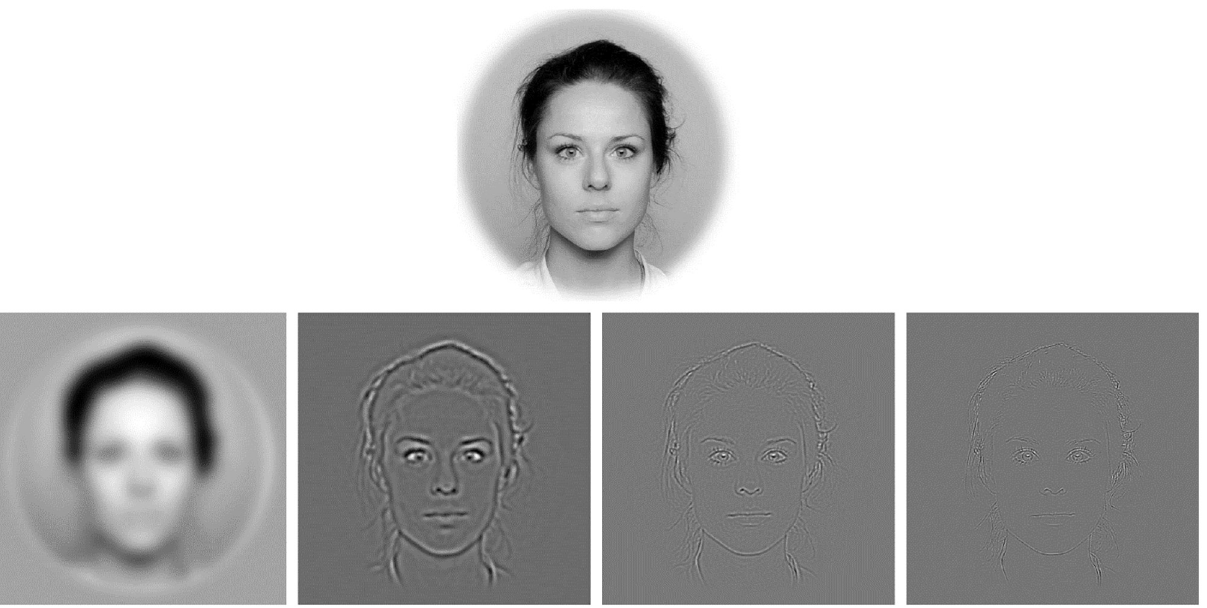
Fig 1. Illustration of the four filtered versions of one of the female faces from the Oslo Face Database. The top image shows the broadband (unfiltered) photo image. Bottom; from left: low-pass filtered face (0.45–4 cpf), medium-low-pass filtered face (11.13–18.76 cpf), medium-high-pass filtered face (25.83–40.5 cpf) and high-pass filtered face (47.65–77.04cpf). Nota Bene: the size of the facial stimuli in this illustration are smaller and with lower resolution than the original photo images as well as the images presented on screen during the experiments.